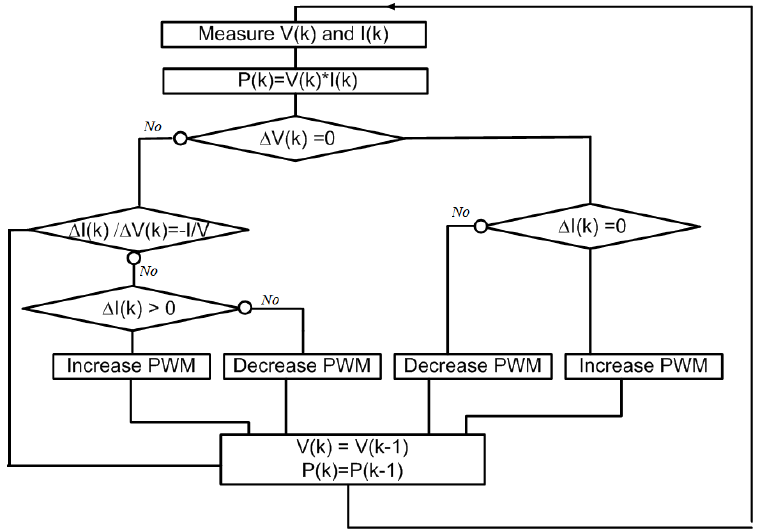
Figure 8. Flowchart of the INC algorithm of the MPPT